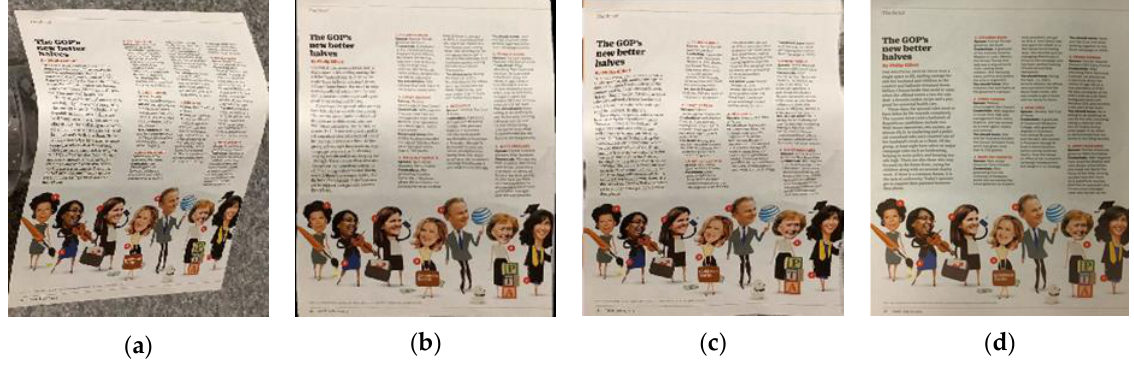
Figure 11. Recent de-warping method comparison. ( a ) warped image ( b ) de-warped image by [36] ( c ) de warping image by [37] ( d ) proposed de-warped image. Table 1. The performance of OCR (error rate Er).